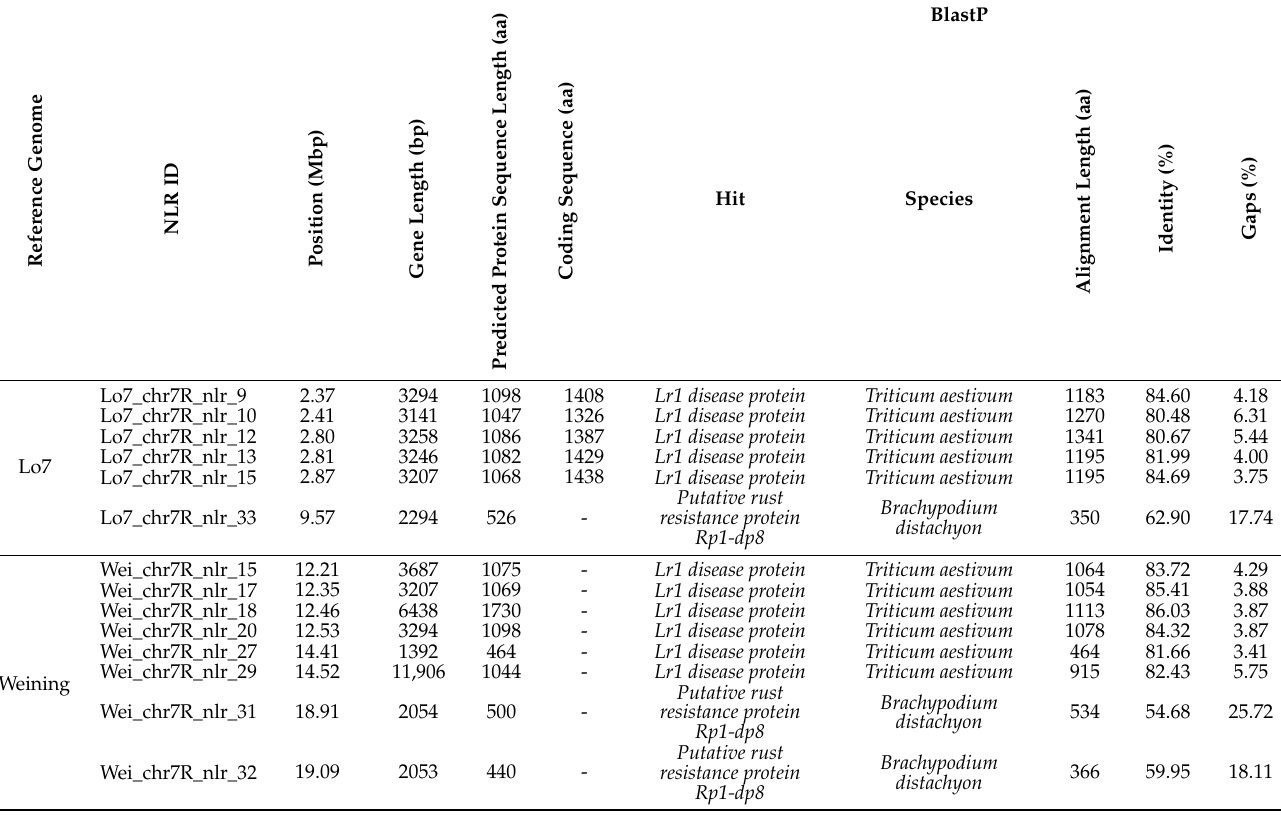
Table 1. Characteristics of nucleotide-binding leucine-rich repeat (NLR) genes residing in leaf resistance-associated region on rye ( Secale cereale L.) chromosome arm 7RS in the reference genomes Lo7 and Weining showing similarity with known leaf rust resistance